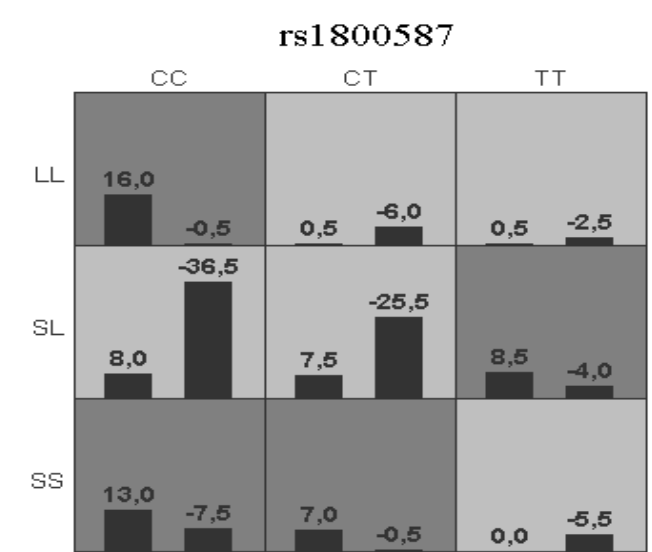
Figure 1. Marginal significant epistasis